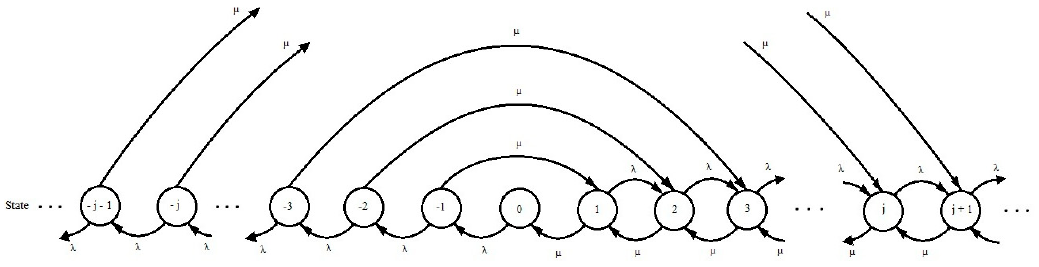
Figure 1. A rate diagram for the continuous-service M/M/1 queueing system.